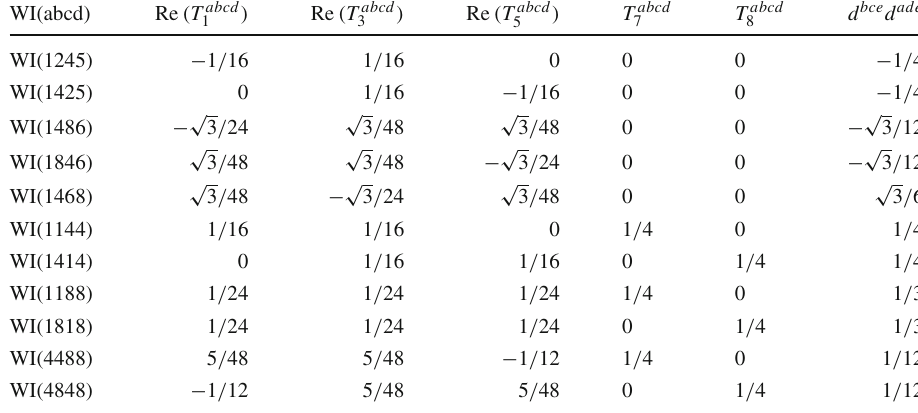
identities (first column), the corresponding flavour factors of Eq. (23) (columns 2 to 6) and the product of symmetric tensors d of the same equation (last